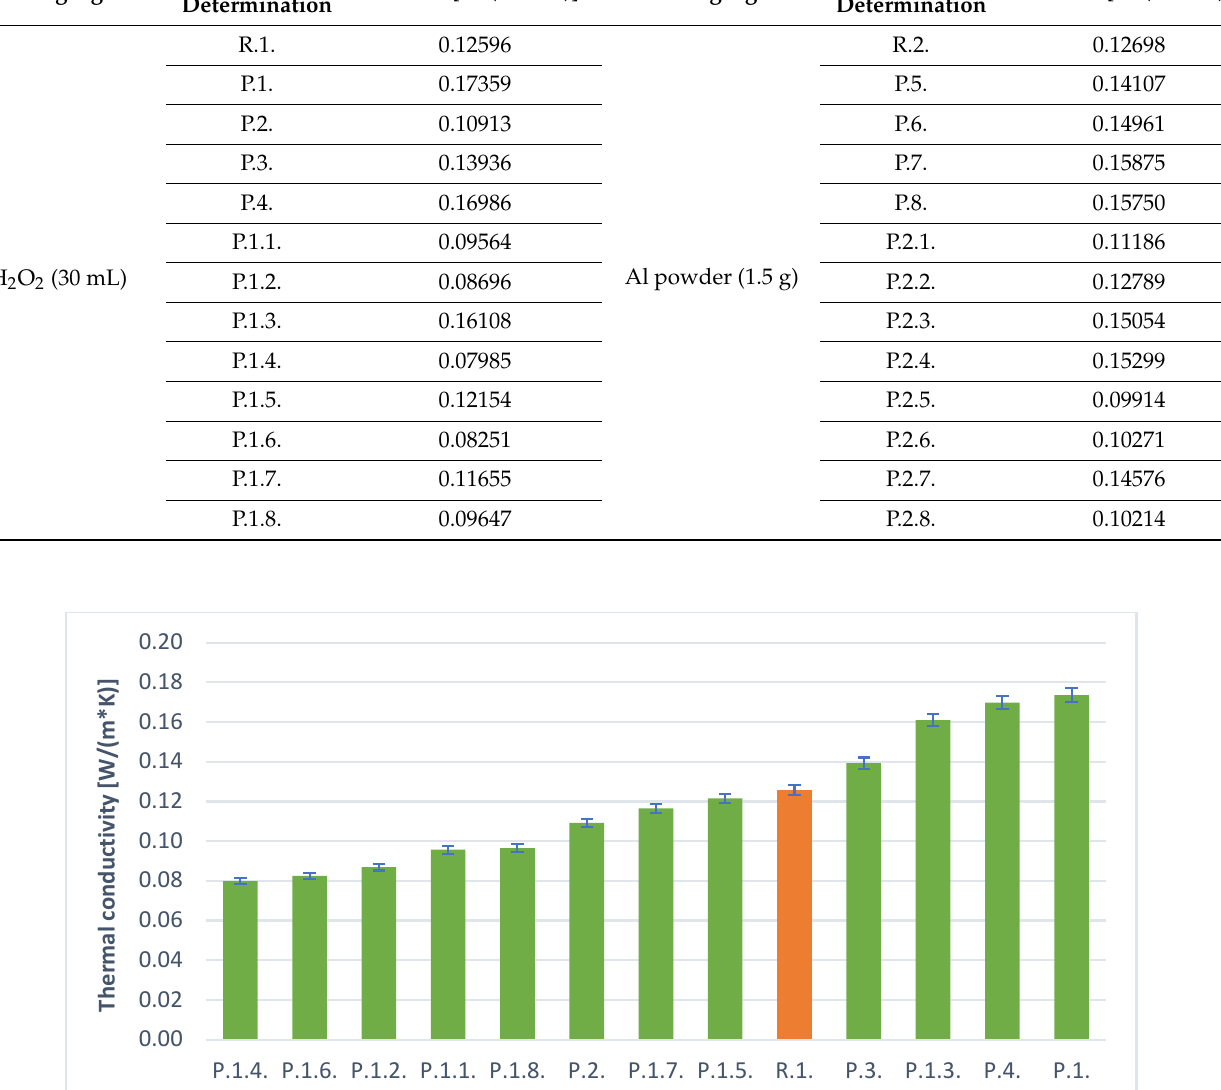
Figure 10. Thermal conductivity of the samples with hydrogen peroxide.